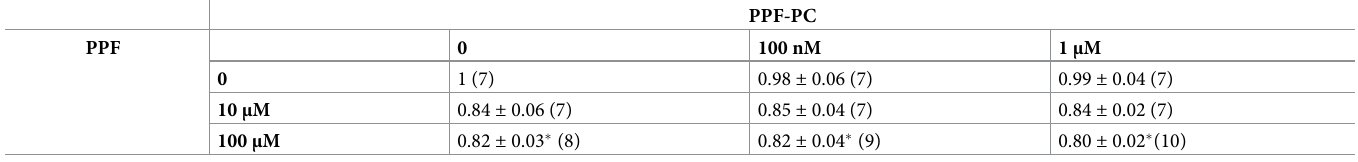
Table 3. Survival ratios (SR) of neurons exposed to PPF (N) = number of dishes.